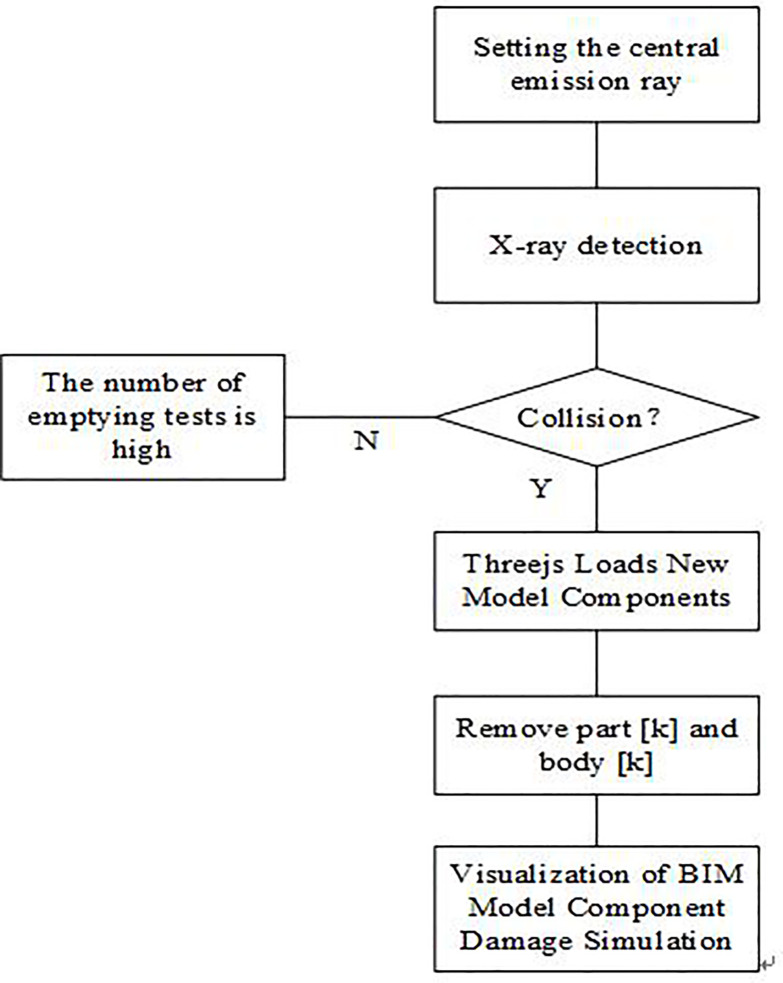
Flowchart of time history method.